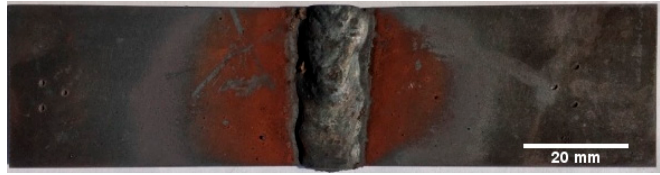
Figure 5. Visual inspection of welded test specimens.